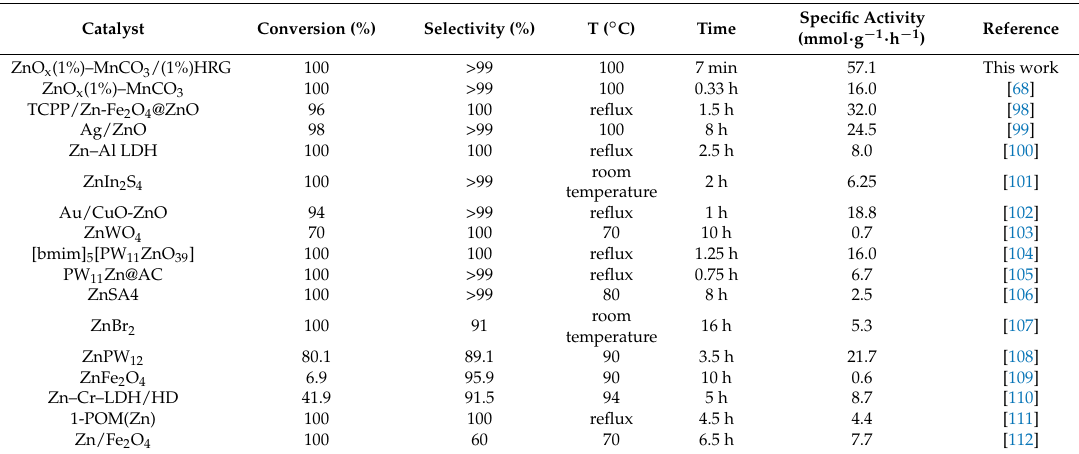
Table 6. Comparison of the ZnO x (1%)–MnCO 3 /(1%)HRG catalyst for the oxidation of benzyl alcohol with previously reported Zn-based